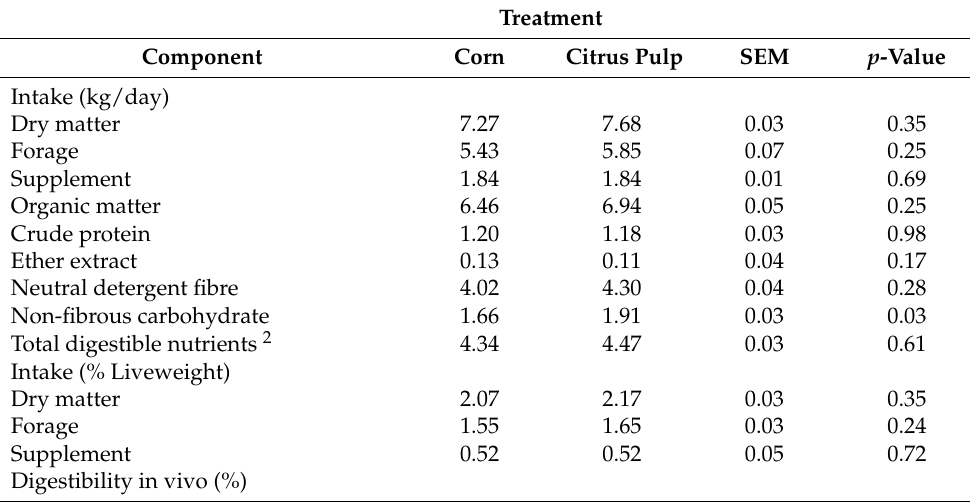
Table 5. Nutrient intake and in vivo digestibility of rumen cannulated Nellore steers grazing Uruchloa brizantha cv Marandu pastures and fed corn or citrus pulp-based supplements during the wet-dry transition period 1